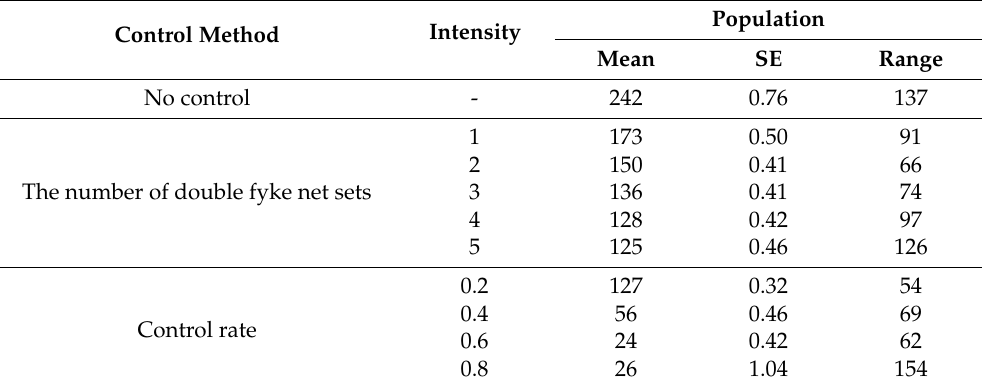
Figure 4. Long-term population dynamics of L. catesbeianus for ( a ) egg and tadpole stages and ( b ) juvenile and adult stages. Results show the mean and standard error (SE) with 30 replicates. Table 2. Variation of the adult population from year 20 to 50 by control method and intensity.